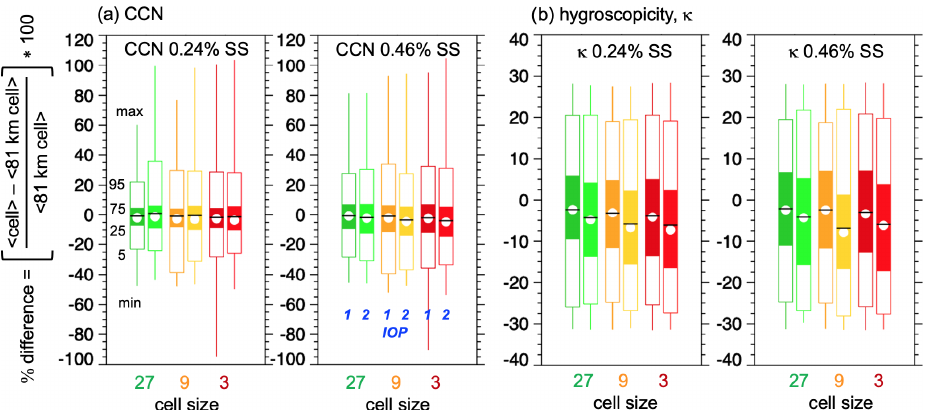
Figure 10. Percent difference between the SGP 81km cell average and the 27, 9, and 3km cell averages of (a) CCN and (b) hygroscopicity, κ , at 0.24% and 0.46% supersaturation. The definition of percentiles and average values is the same as Fig. 5. All flights during IOPs 1 and 2 are grouped by the darker (left) and lighter (right) colors,